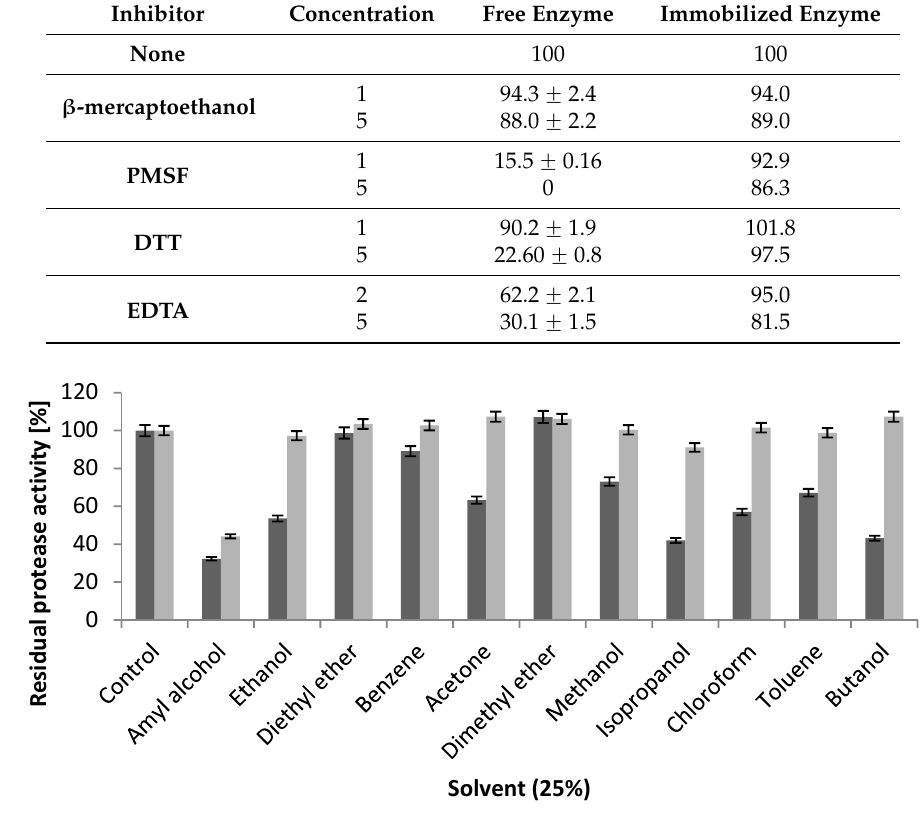
Table 3. Influence of some inhibitors on the catalytic activity of free and immobilized NPST-AK15 protease. The standard deviations were in the range of 1.5%–3.2%.